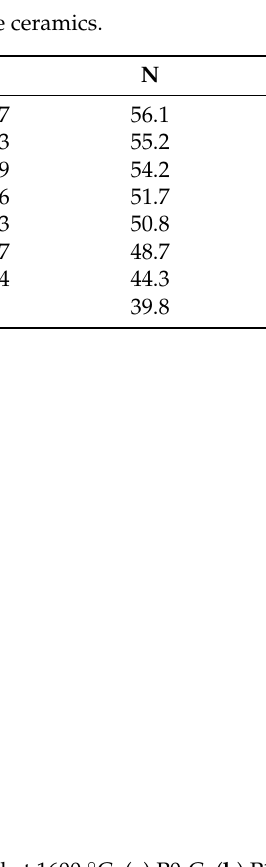
Figure 3. XRD patterns of the composite ceramics pyrolyzed at 1600 ◦ C: ( a ) P0-C; ( b ) P1-C; ( c ) P2-C;